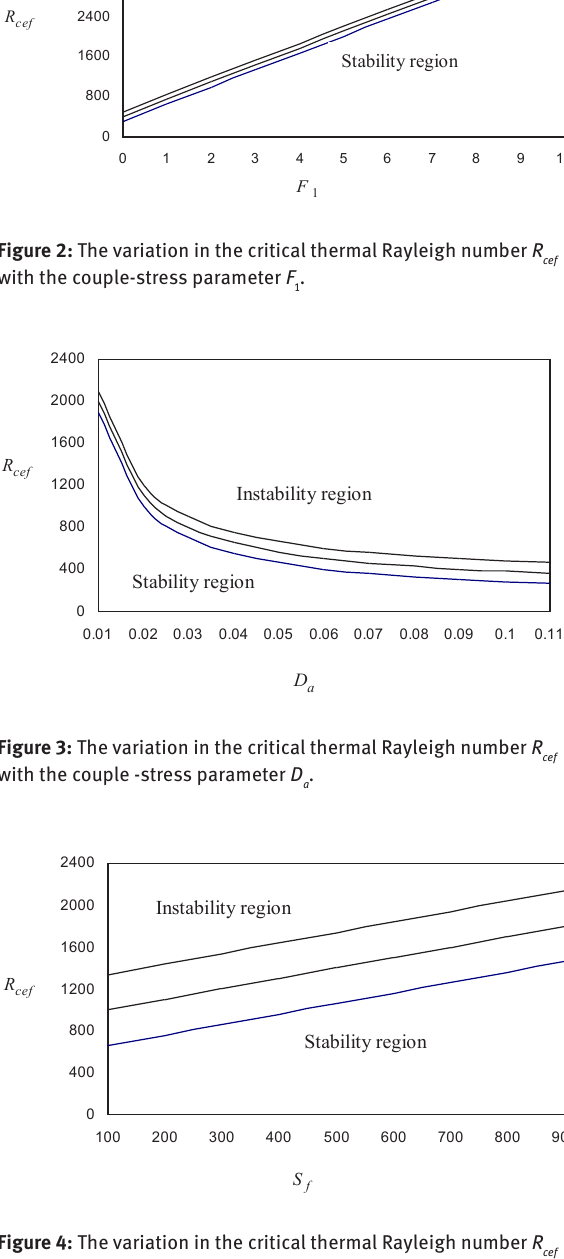
cef R with the solute cef